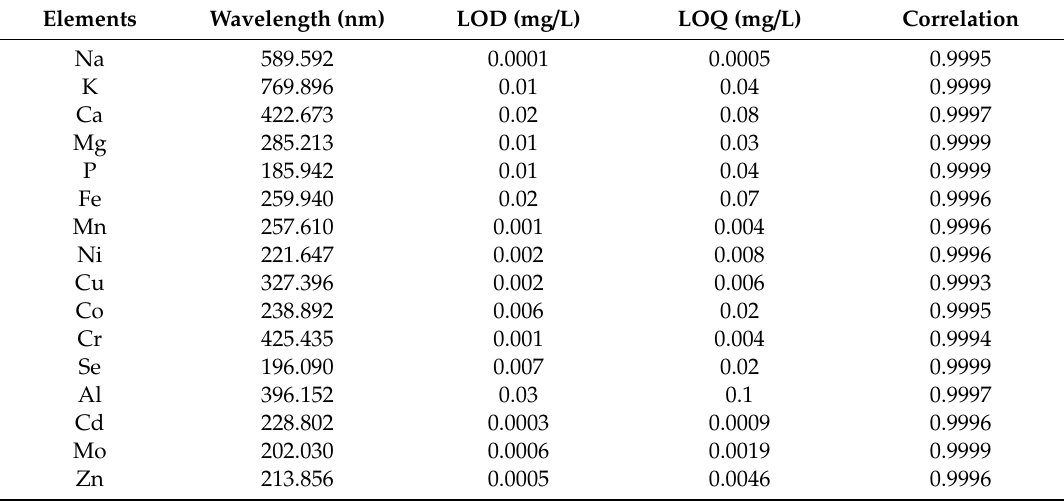
Table 6. Operating conditions used in the analysis by ICP